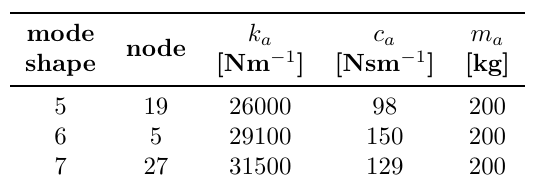
Table 2. TMDs designed to reduce vibration of the 5th, 6th, and 7th mode